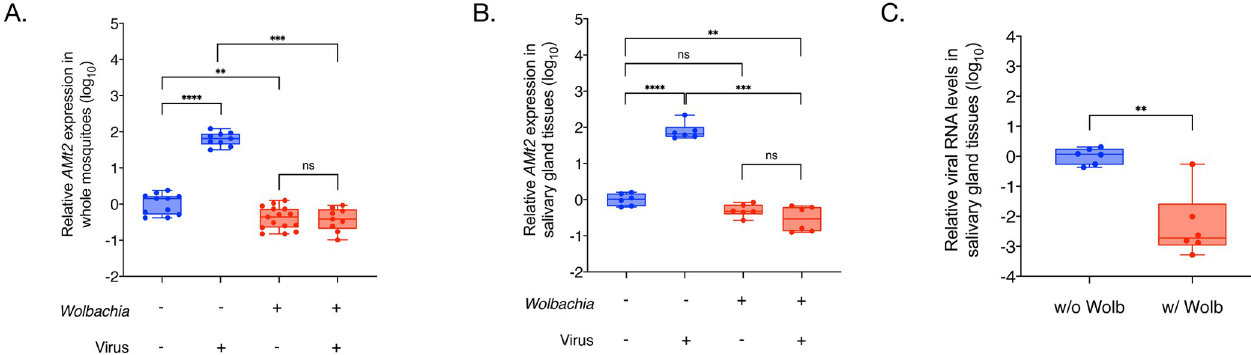
Fig 1. Virus and Wolbachia each differentially modulate expression of the RNA methyltransferase gene DNMT2 in mosquitoes. (A) AMt2 expression was measured 5 days post bloodmeal in whole female mosquitoes using qRT-PCR with and without SINV. Error bars represent standard error of mean (SEM) of biological replicates. Two-way ANOVA with Tukey’s post-hoc test of multivariate comparisons. (B) AMt2 expression measured in dissected salivary gland tissues collected from female mosquitoes with and Wolbachia -free 5 days post bloodmeal with or without SINV. Error bars represent standard error of mean (SEM) of biological replicates. Two-way ANOVA with Tukey’s post-hoc test of multivariate comparisons. (C) Viral RNA levels were quantified in dissected salivary gland tissues with and Wolbachia -free using qRT-PCR at 5 days post infectious blood meal with SINV. Unpaired, student’s t-test, error bars represent standard error of mean (SEM) of biological replicates. For all panels: ���� P < 0.0001; ��� P < 0.001; �� P < 0.01; ns = non-significant.